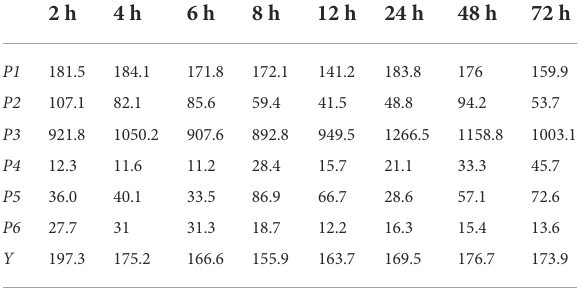
chromatographic peak was calculated using multiple linear regression analysis, as shown in Eq. 14.